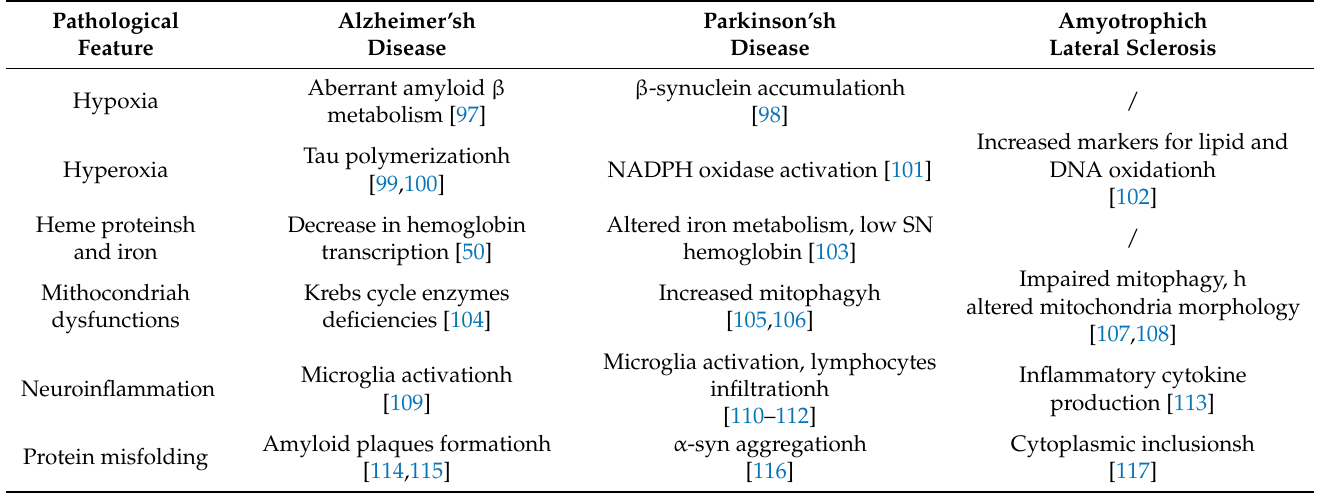
Table 1. Summarized pathological features related to oxidative stress in adult neurodegenerative